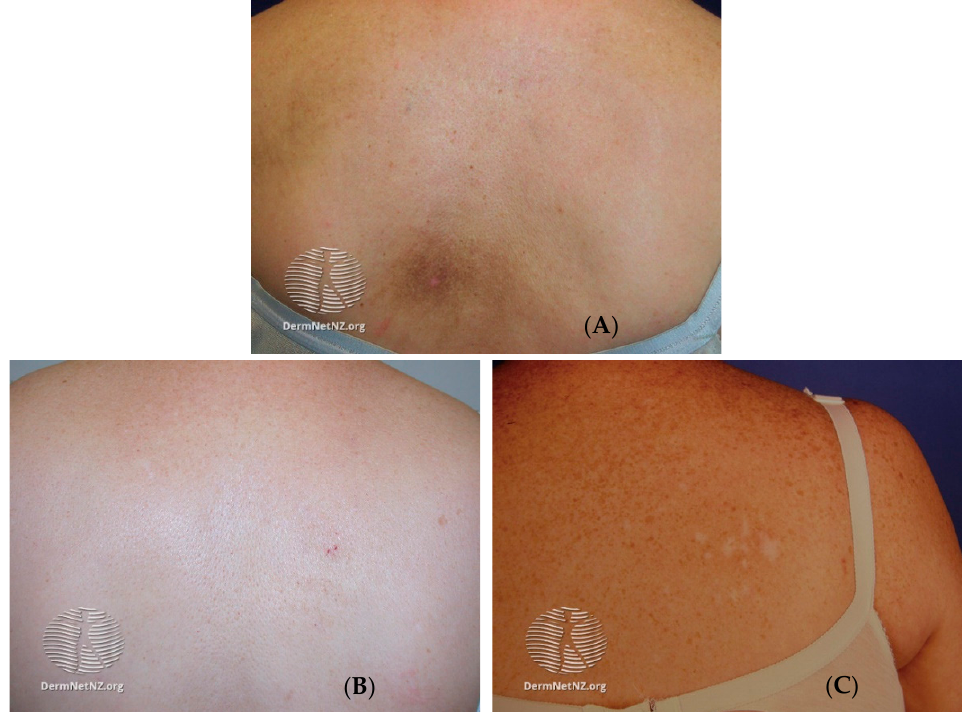
Figure 1. The dermatological sequelae from the scratching in notalgia paresthetica. ( A ). Hyperpigmentation. ( B ). Scratch marks. ( C ). Scarring from excessive scratching. Images provided by Dermnet.